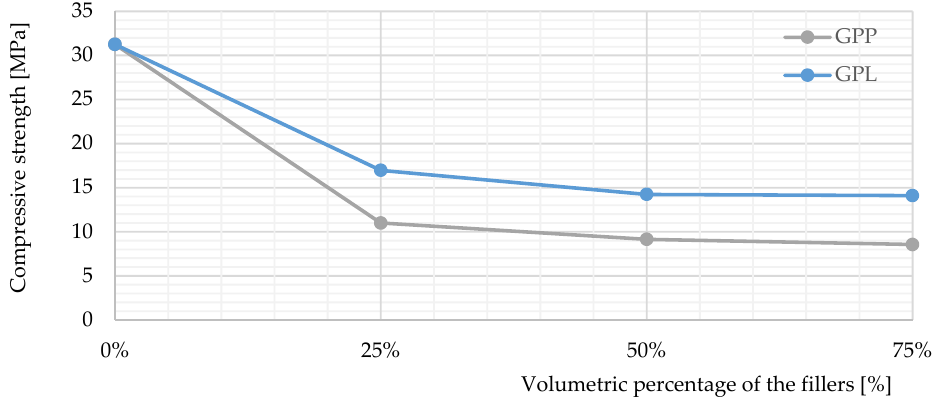
Figure 5. The compressive strength profiles of GPL and GPP through the volume fraction of the fillers.